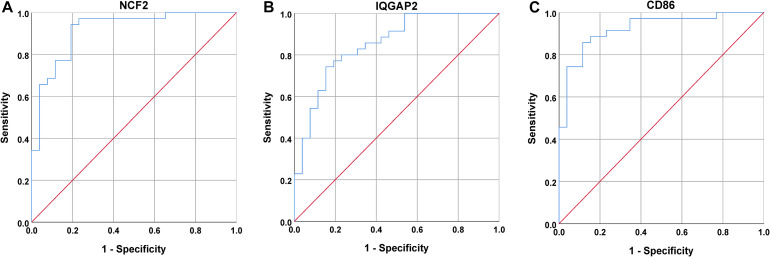
ROC curves for NCF2, IQGAP2, and CD86. (A) The AUC for NCF2 was 0.918. (B) The AUC for IQGAP2 was 0.853. (C) The AUC for CD86 was 0.903.